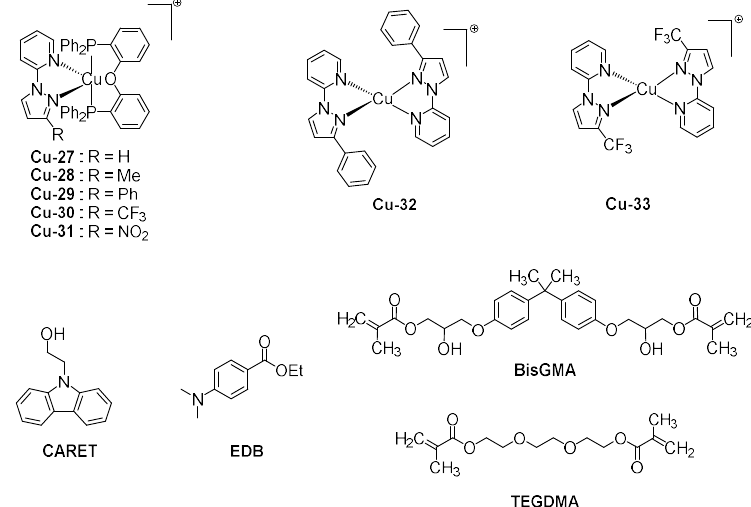
Figure 12. Chemical structures of Cu-21 – Cu-26 .